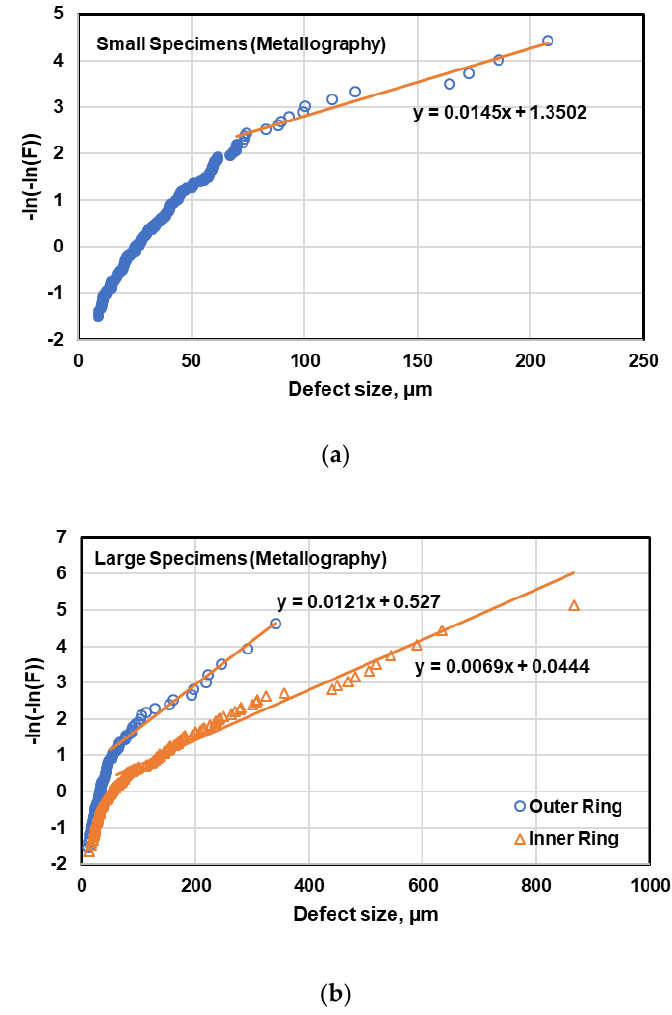
Figure 16. Extreme value (EV) plot of defect data for ( a ) small and ( b ) large specimens.